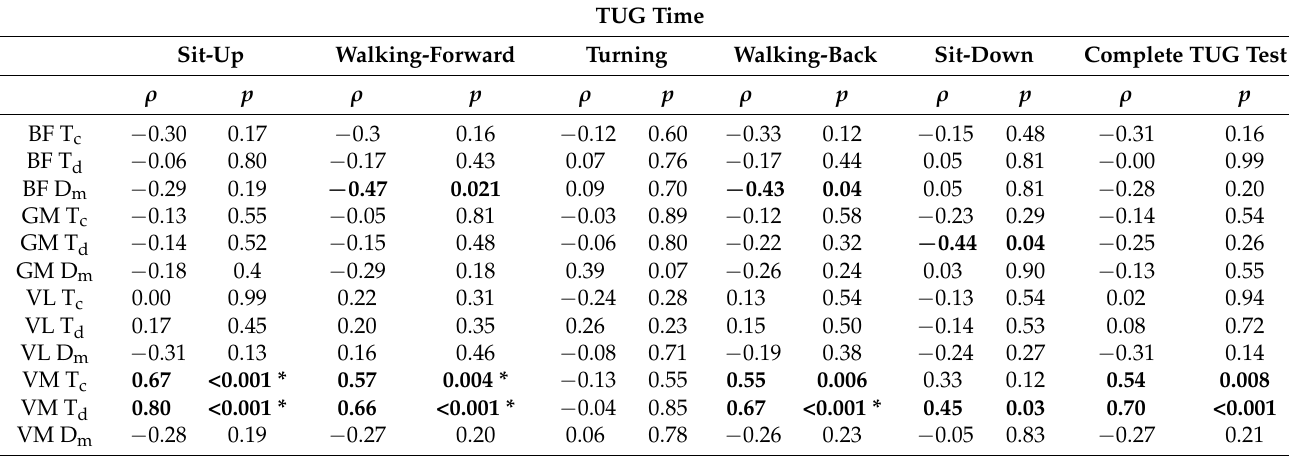
Table 3. Spearman correlation ( ρ ) results between Timed Up-and-Go test (TUG) subtasks, the complete TUG time, and tensiomyographic (TMG) parameters. Cases with p -values less than 0.05 are marked as bold. Those with p -values less than 0.0042 (Bonferroni correction) are marked with